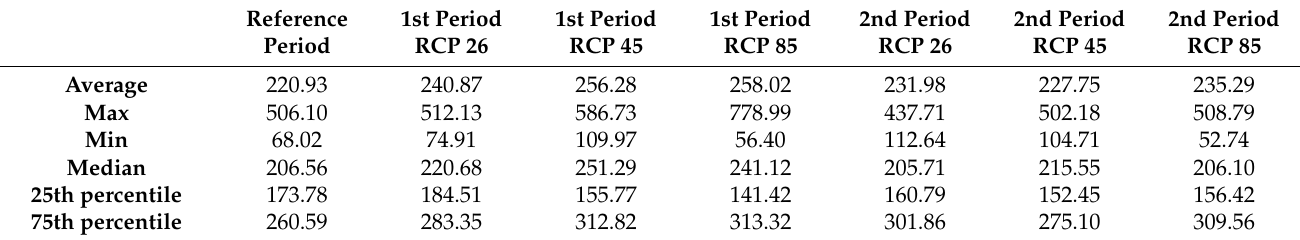
Table 5. MFI statistics for the reference period and climate